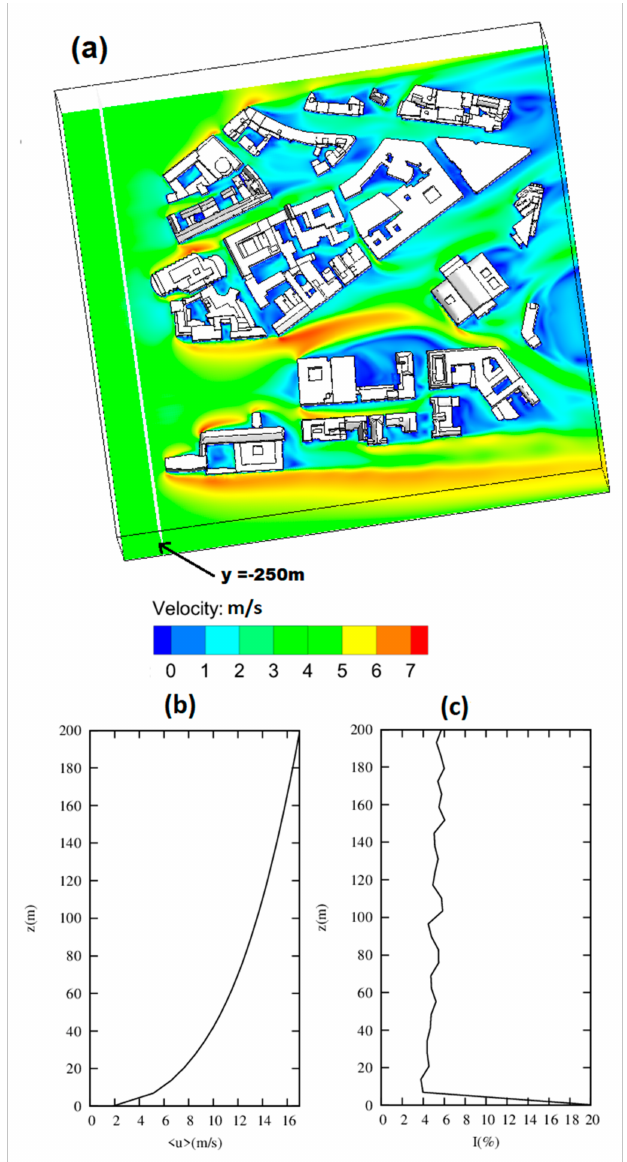
Figure 5. Characteristics of approaching flow: ( a ) Velocity at z = 3 m, ( b ) mean streamwise velocity < u > at y = − 250 m, ( c ) turbulent intensity at y = − 250